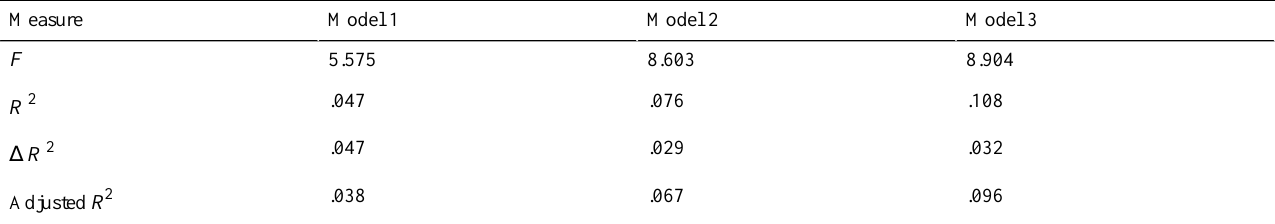
Table 5. Statistical measures of the 3 models of the multivariable analysis ( P <.001 for all